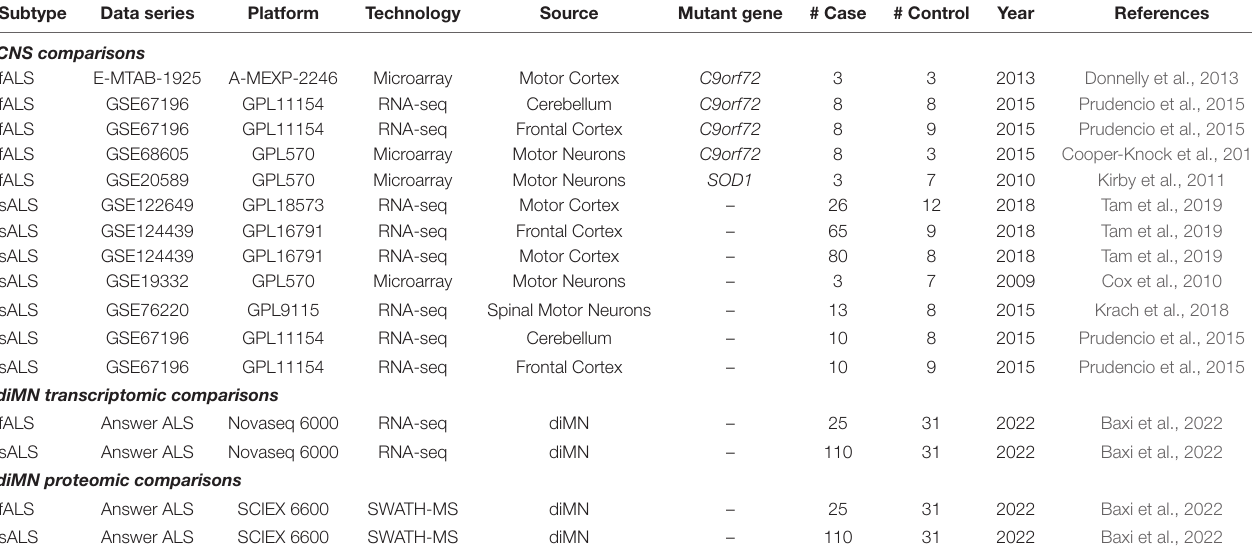
TABLE 1 | ALS case-control comparisons using CNS and diMN